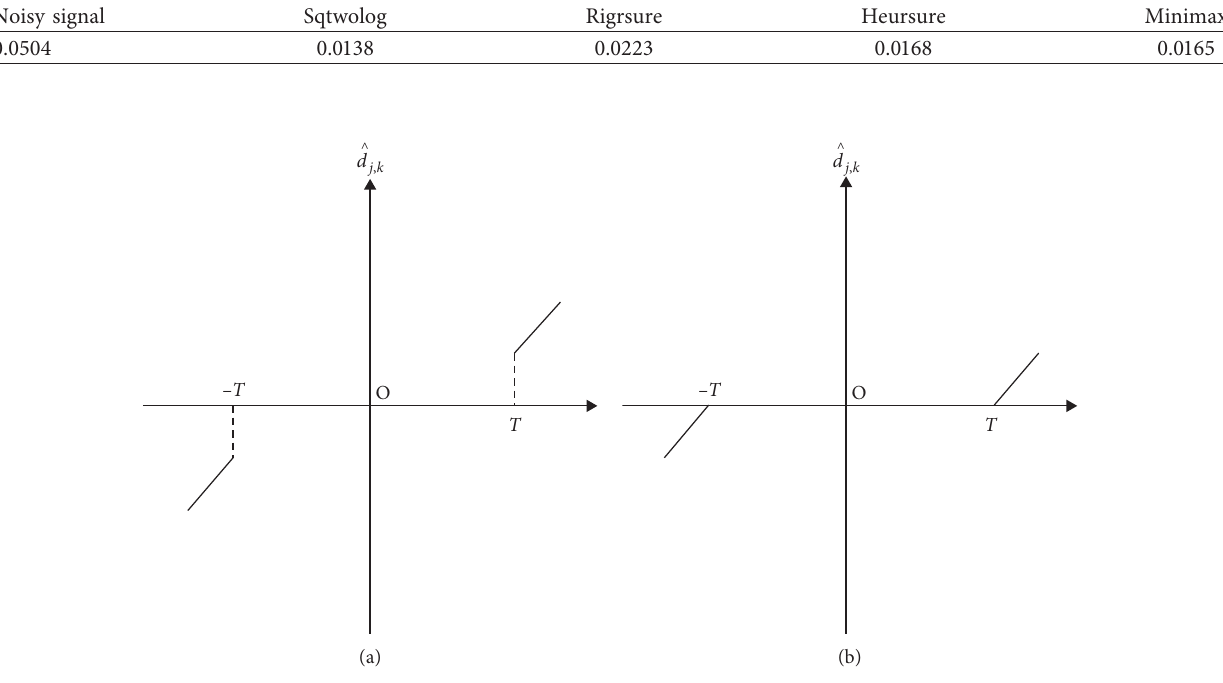
Figure 2: Threshold function. (a) Hard threshold function. (b) Soft threshold